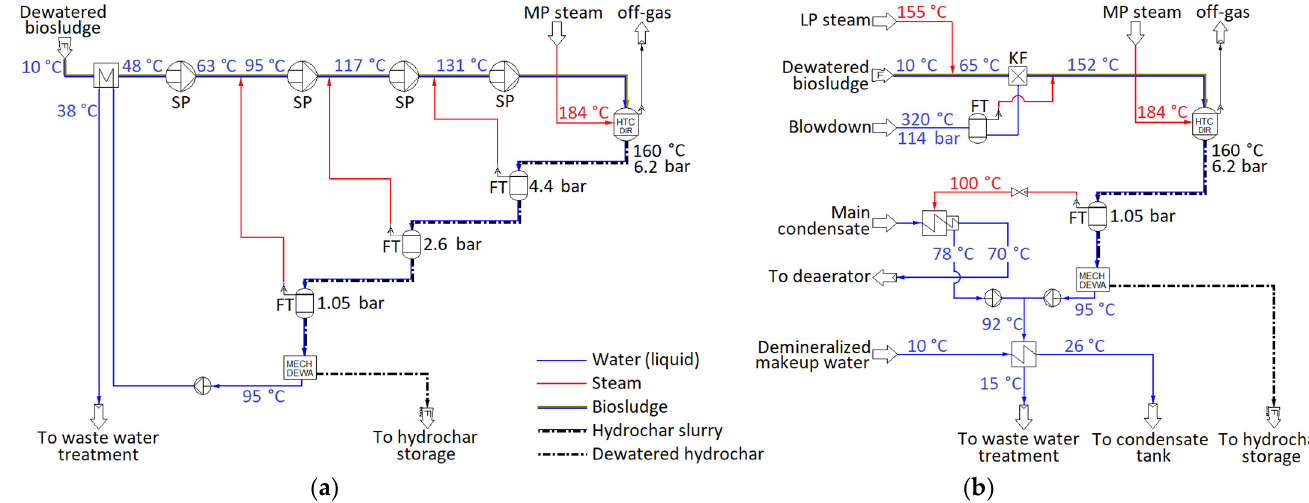
Figure 3. Biosludge HTC treatment plants. Case A ( a ) represents a stand-alone plant with recuperative heat recovery connected to the mill only through the MP steam usage. Case B ( b ) represents a simplified HTC plant with waste heat recovery to the steam cycle.